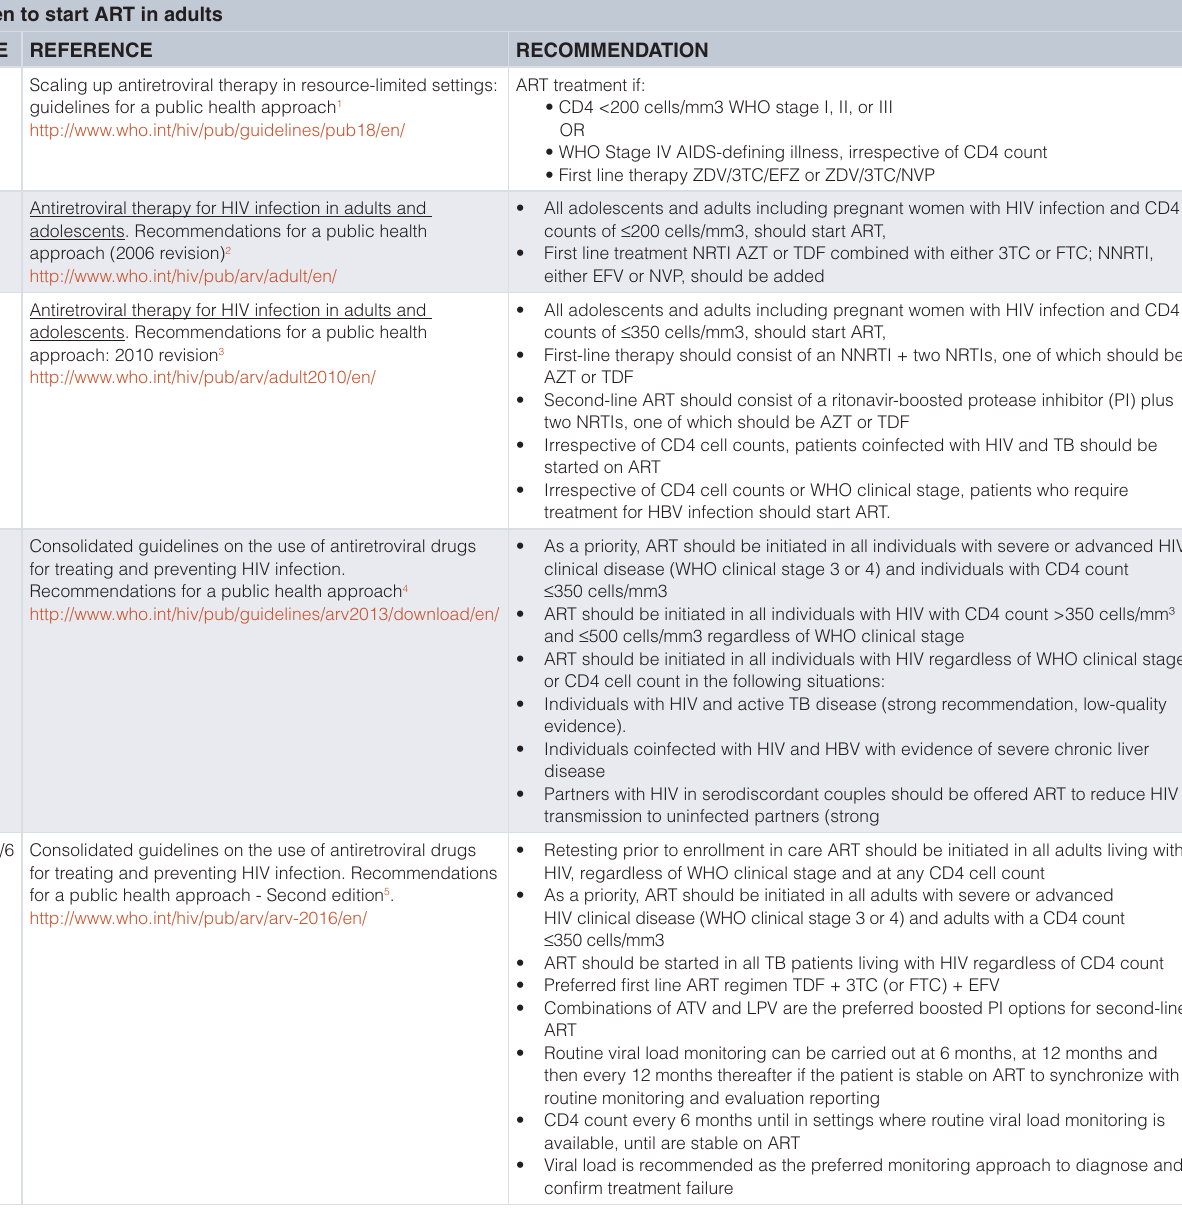
Table 4. Summary of key features of World Health Organisation